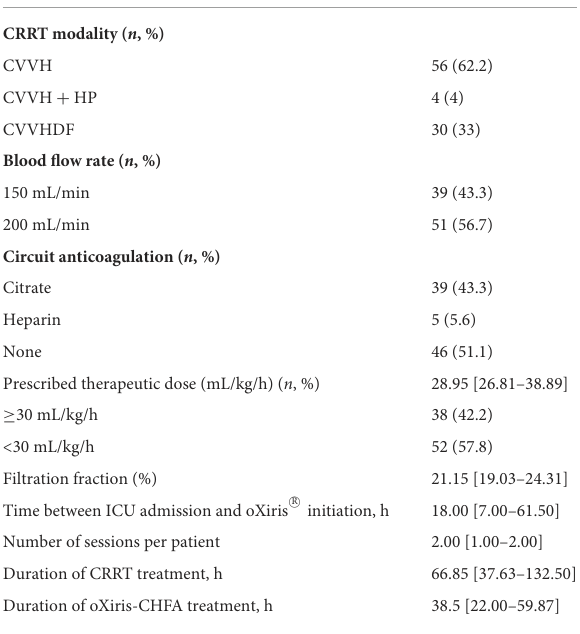
TABLE 2 CRRT prescription in each